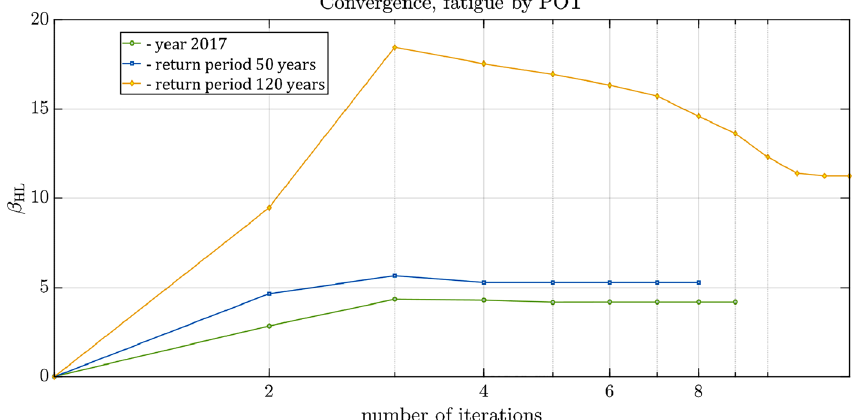
Fig. 14 Convergence for the reliability index 𝛽 , fatigue by POT